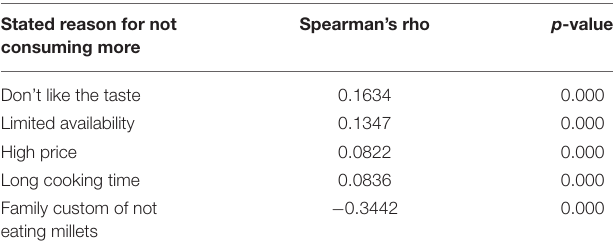
TABLE 6 | Spearman’s coefficient of correlation between frequency of consumption and their reason for not consuming more millets and sorghum ( n = 13,840).